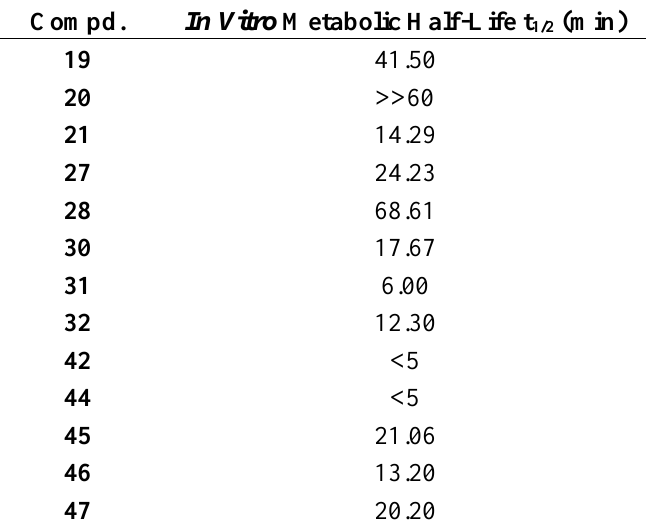
Table 8. Results of metabolic stability study.